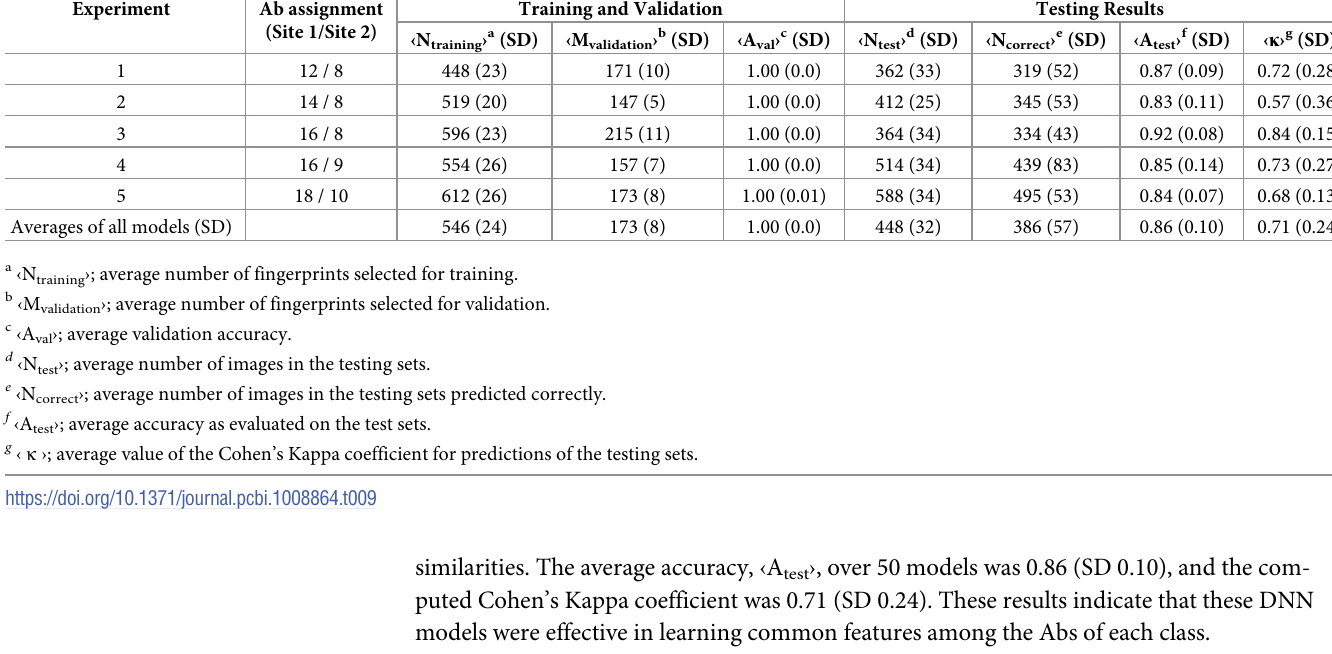
Table 10 show a summary of twelve DNN models based on the RCAE method for OCC.